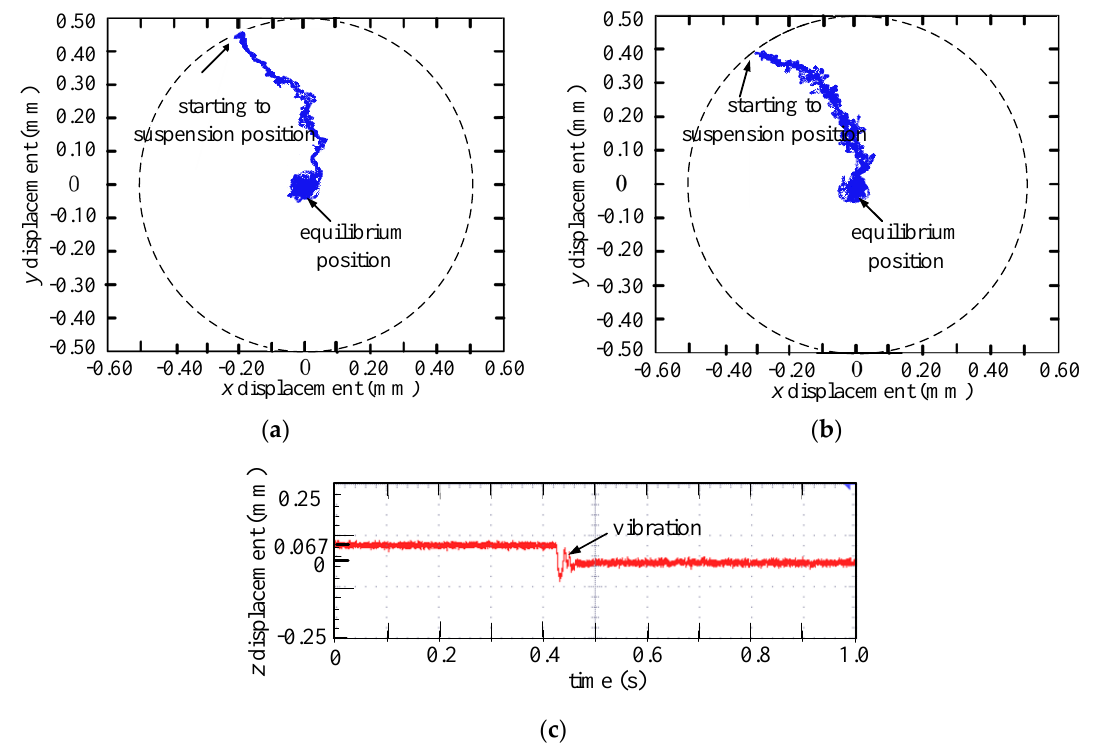
Figure 6. Trajectories and displacement waves of the rotor adopting “switching model” at the start-of-suspension state. ( a ) Mass center orbit of the rotor under the support of the AC 2-DOF HMB; ( b ) Mass center orbit of the rotor under the support of the AC–DC 3-DOF HMB; ( c ) Displacement waveforms of the rotor under the support of the AC–DC 3-DOF HMB.